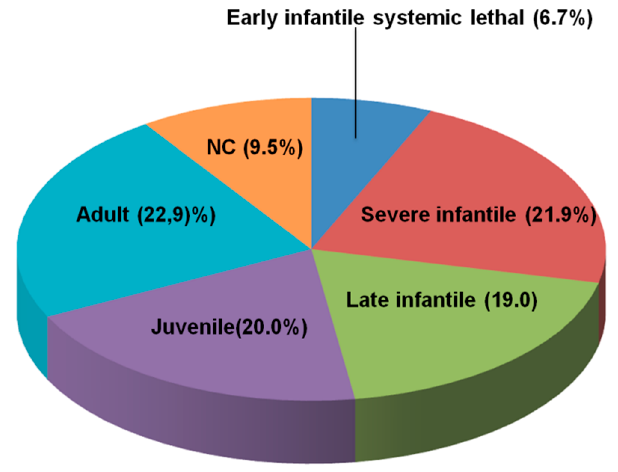
Figure 1. Relative distribution of the clinical phenotypes of Niemann–Pick type C1 (NPC1) patients based on the age at onset of first neurological signs. Severe infantile (SI): age at onset < 2 years; Late infantile (LI): age at onset 2–6 years; Juvenile (J): age at onset 6–15 years; and Adult (A): age at onset ≥ 15 years. Patients who died during the first month of life due to liver or respiratory insufficiency without signs of neurological involvement were classified as early infantile systemic lethal form (EISL). NC: not classifiable.